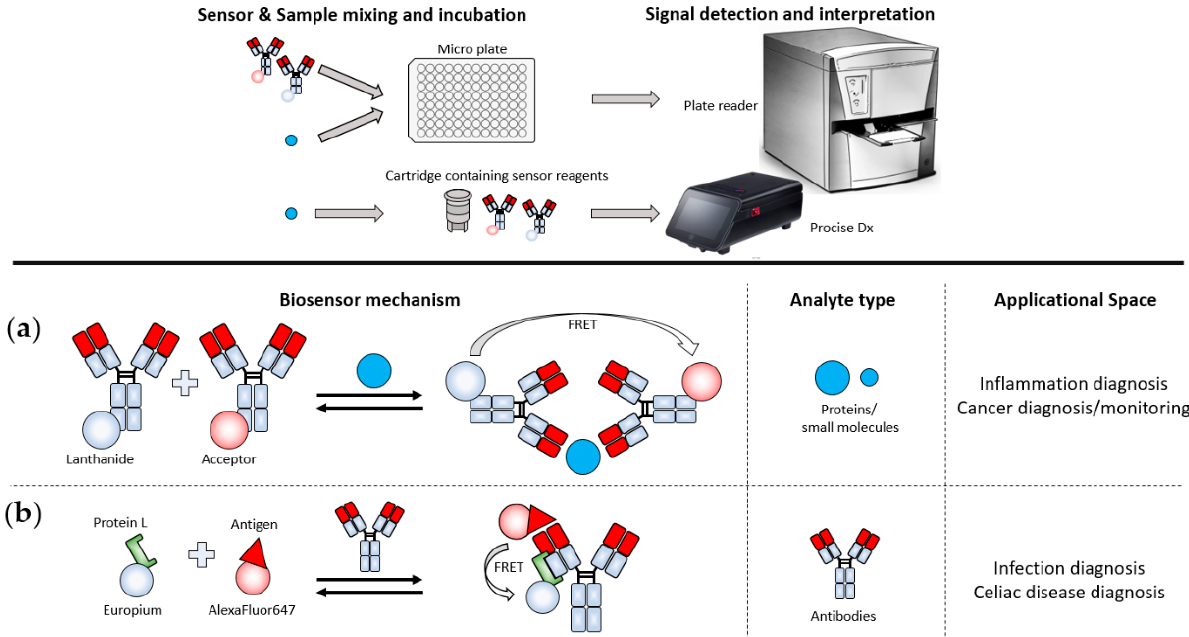
Figure 5. Examples of Lanthanide-FRET (LRET) applications that are potentially suitable for on-site testing. ( a ) Commonly applied TR-FRET technologies rely on a sandwich-based homogeneous assay, where two antibodies targeting different epitopes of the analyte are labeled with a lanthanide energy donor, while the other is labeled, with an organic dye or fluorescent protein, as the energy acceptor. Binding of both antibodies enables FRET between the lanthanide and acceptor which is measured by their altered fluorescence lifetimes. ( b ) Protein L, an antibody light-chain-binding protein [102], is labeled with Europium. Antigens to an antibody of interest are labeled with the organic dye AlexaFluor647 (LFRET) [103]. If a sample contains antibodies against the antigen–dye fusion, FRET occurs between Protein-L-Europium bound to the light chain of the antibody and the Antigen–AlexaFluor647 fusion. Image of the ProciseDx device was used with permission from